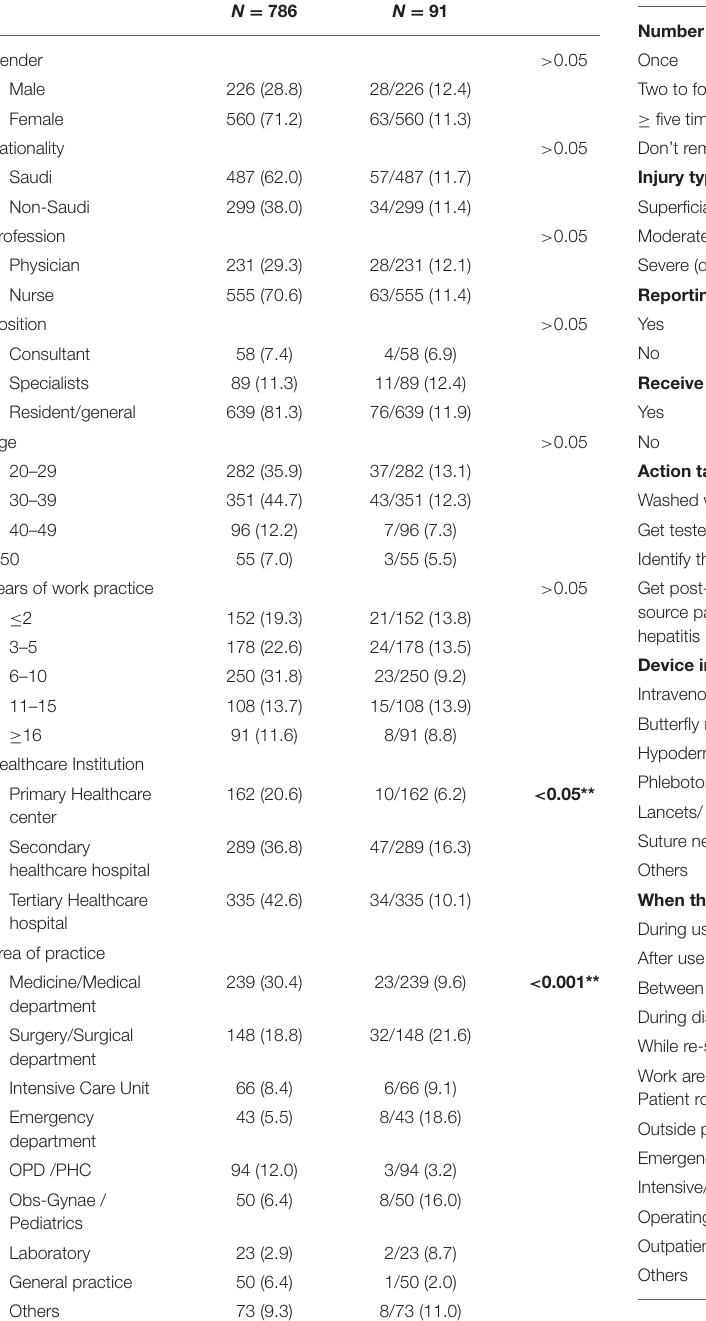
( Table 2 ). Out of 786 respondents, 94.7% knew about the definition of NSI, and 82.4% of them were aware of sharps disposal containers recommendation, whereas 61.2% recognized the recap of the needle was not recommended. The majority of respondents (78.9%) gave a correct answer regarding the doses of the